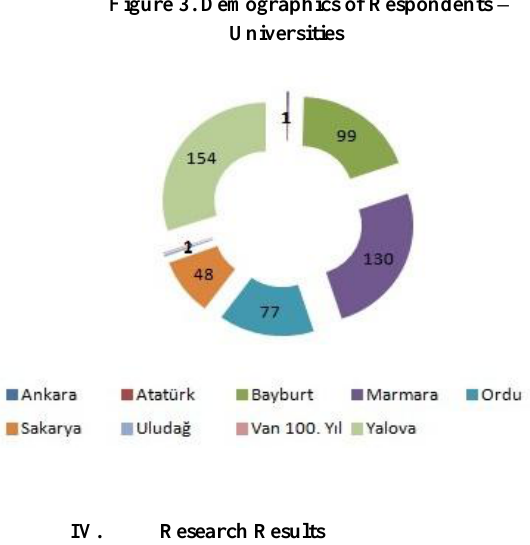
Figure 3. Demographics of Respondents –